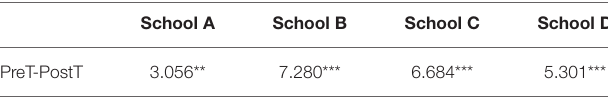
TABLE 5 | Comparisons between pre-, and post-tests for each of the schools presented as t -test statistics.